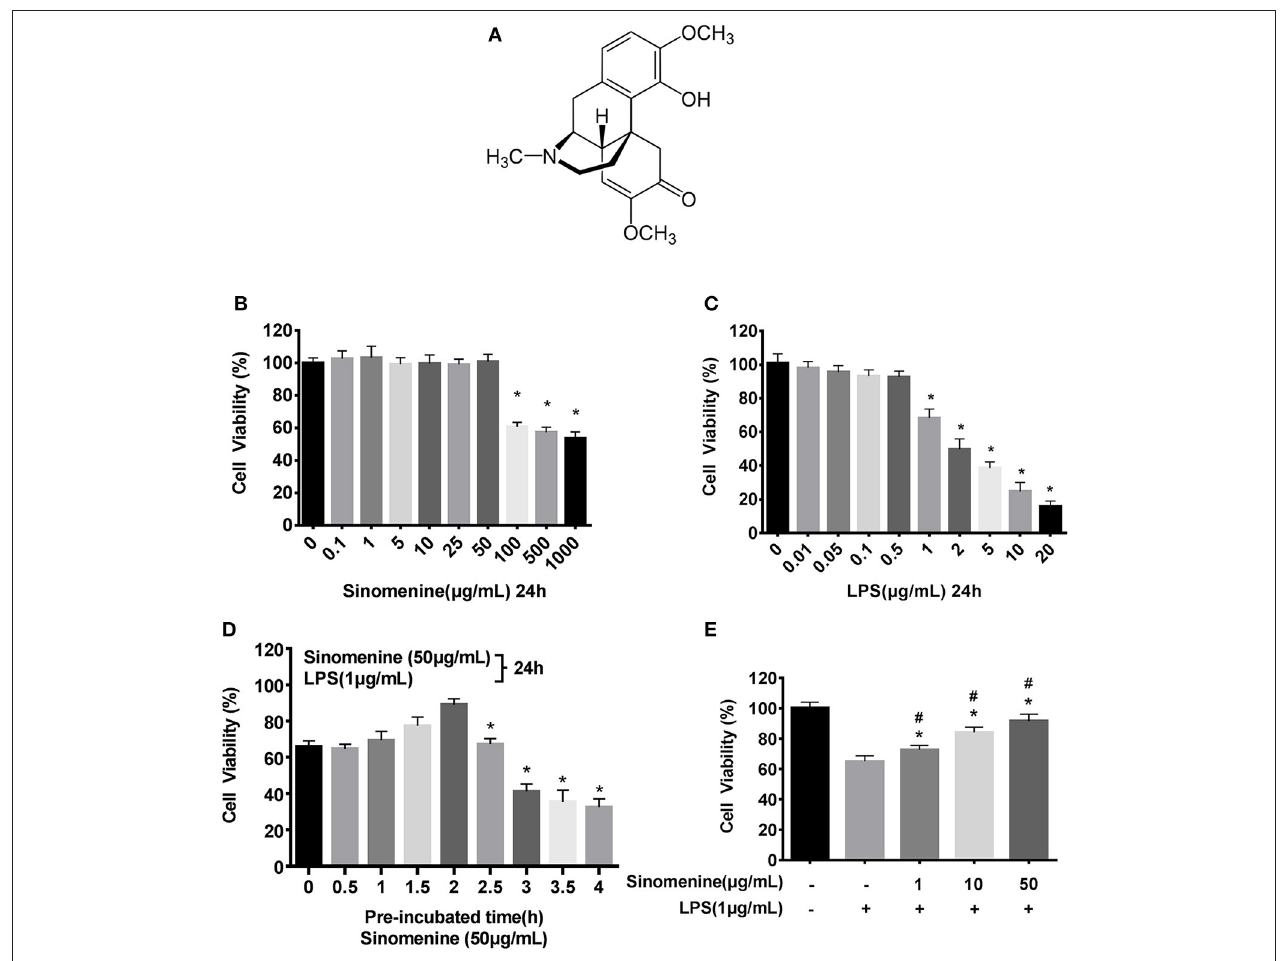
FIGURE 1 | SIN prevents LPS-induced cell injury. Cell viability was determined by the CCK-8 assay, and the viability of untreated RAW264.7 was assessed as 100%. (A) Chemical structure of Sinomenine (SIN), CAS number: 115-53-7. (B) RAW264.7 cells were incubated with SIN (0–1000 µ g/mL) for 24h. (C) RAW264.7 cells were treated with various concentrations of LPS (0–20 µ g/mL) for 24h (* P < 0.05 vs. control). (D) RAW264.7 cells were pre-treated with 50 µ g/mL SIN for 0–4h and then co-stimulated with LPS (1 µ g/mL) for another 24h (* P < 0.05 vs. 2h pre-treated). (E) RAW264.7 cells were pre-incubated with 0, 1, 10, 50 µ g/mL SIN for 2h and co-stimulated with 1 µ g/mL LPS for another 24h. Data are presented as mean ± SD values of four independent experiments (* P < 0.05 vs. control, # P < 0.05 vs. LPS treated RAW264.7